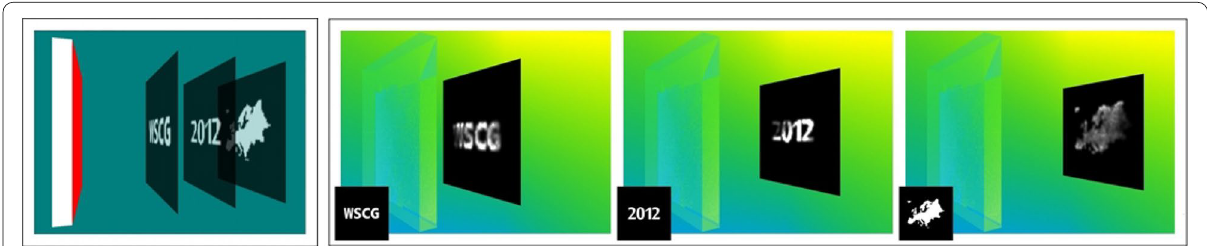
Fig. 21 The approach proposed by Tandianus et al.[50] allows the user to create an object that can form multiple caustic patterns at different